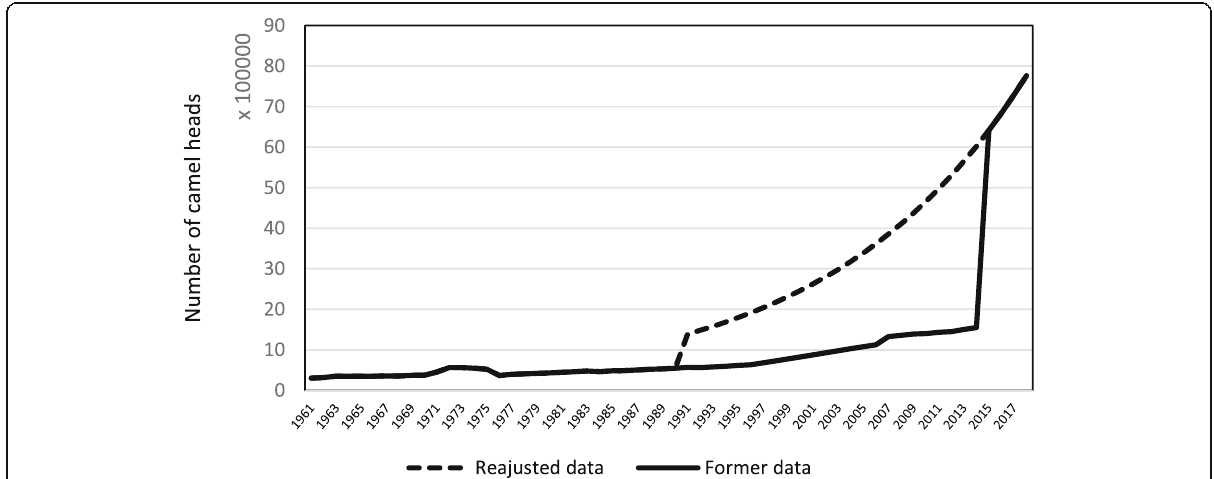
Fig. 9 Demographic changes of camel population in Chad 1961 – 2018 before and after readjustment following the camel census occurring